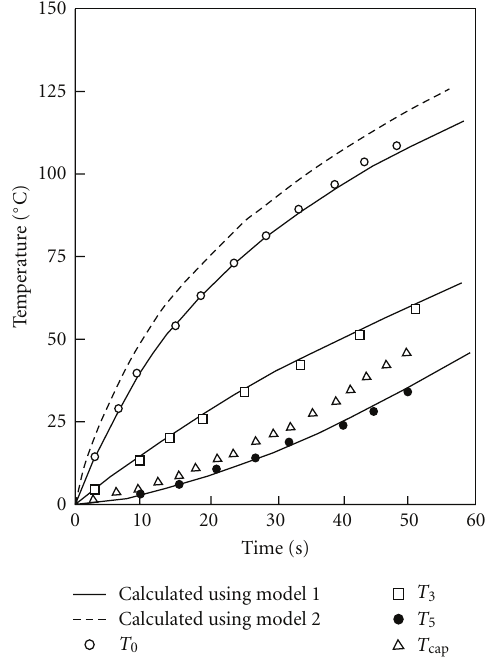
Figure 9: Comparison between calculated values and measured values.